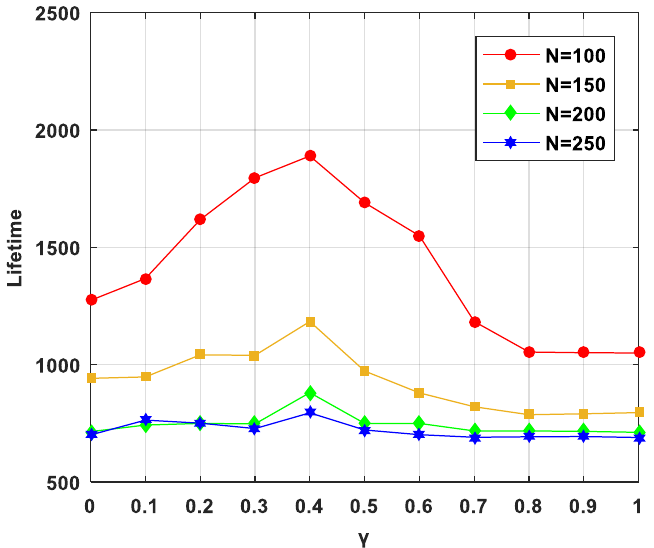
 for different node numbers. Figure 3. Network lifetime with di ff erent values of γ for di ff erent node